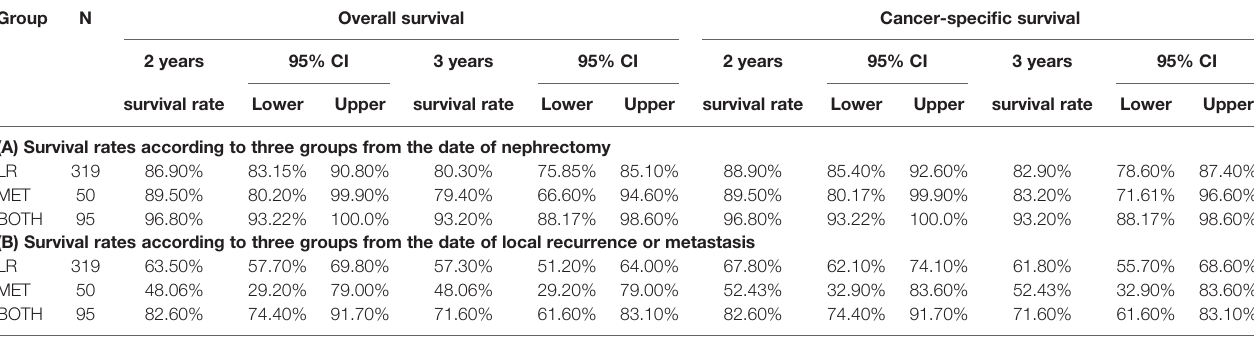
TABLE 4 | Survival rate of 2 and 3 years according to three groups (A) from the date of nephrectomy and (B) from the date of local recurrence or metastasis.